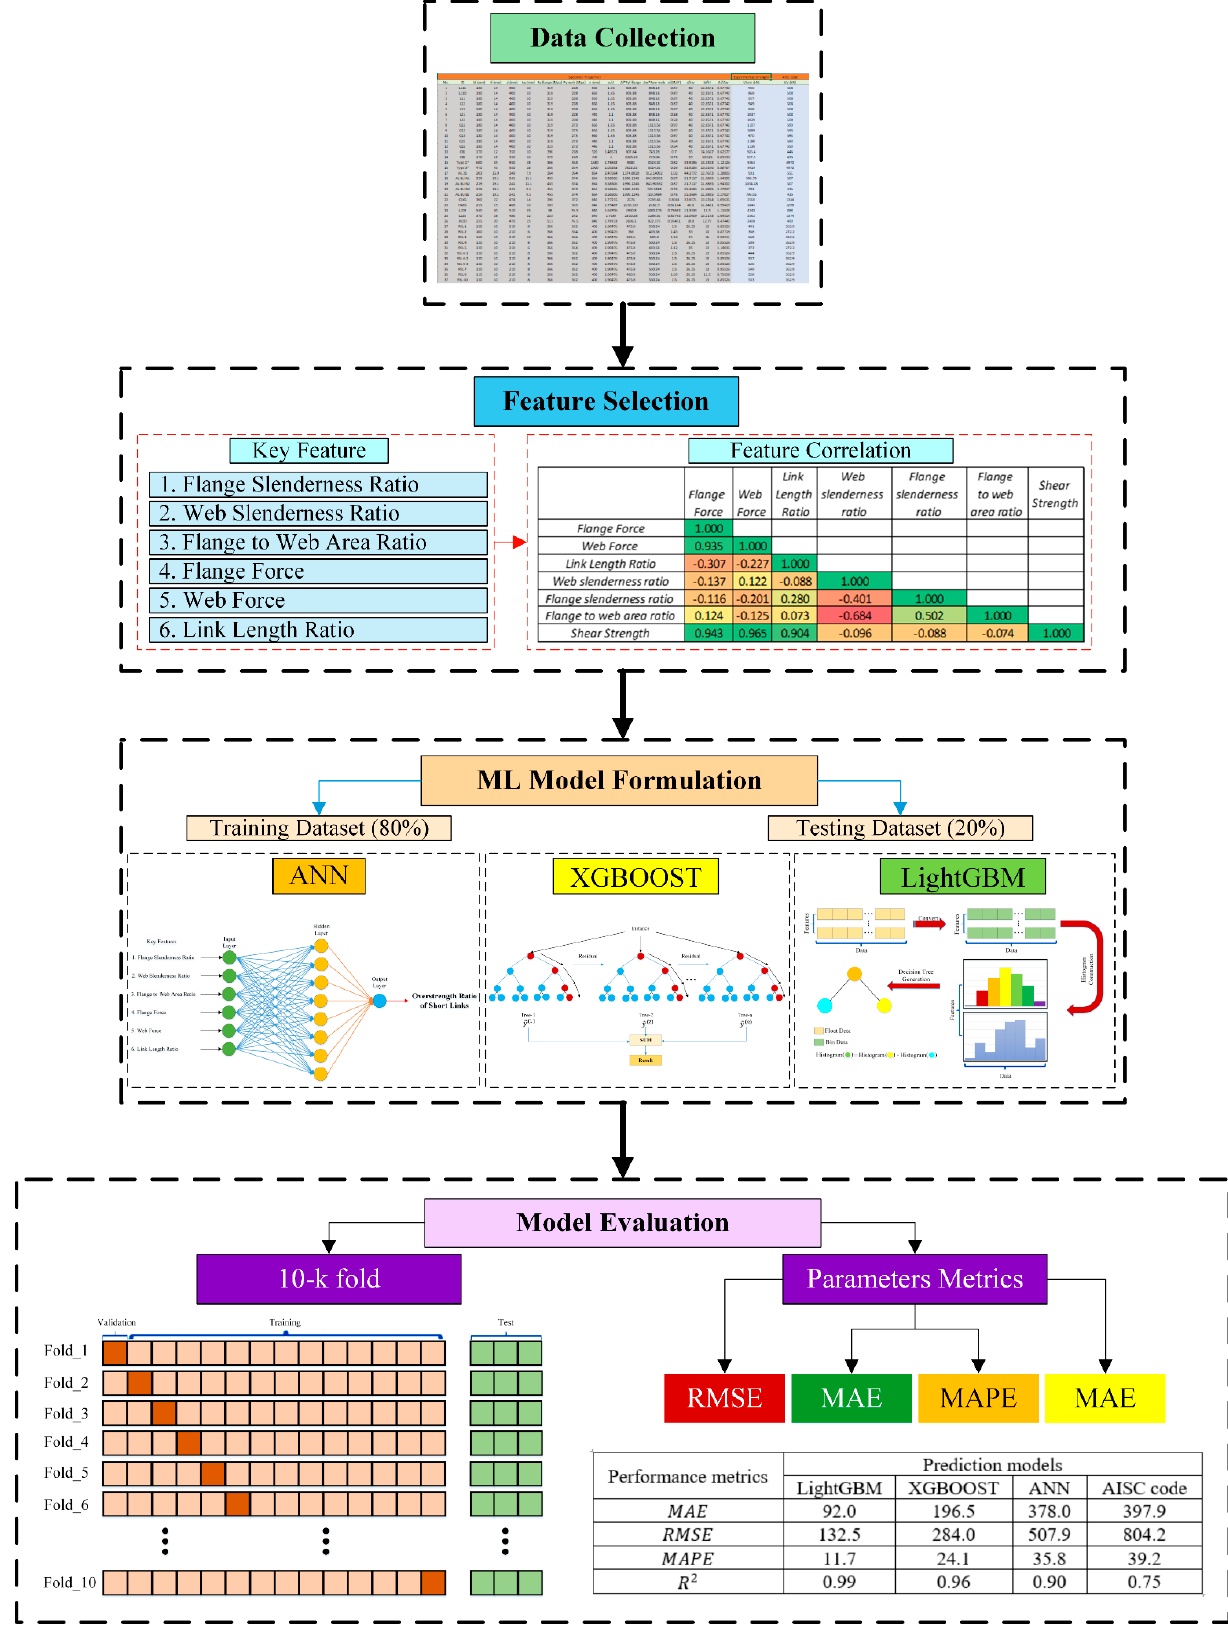
Figure 1. Processing structure for prediction of the short links’ shear strength.